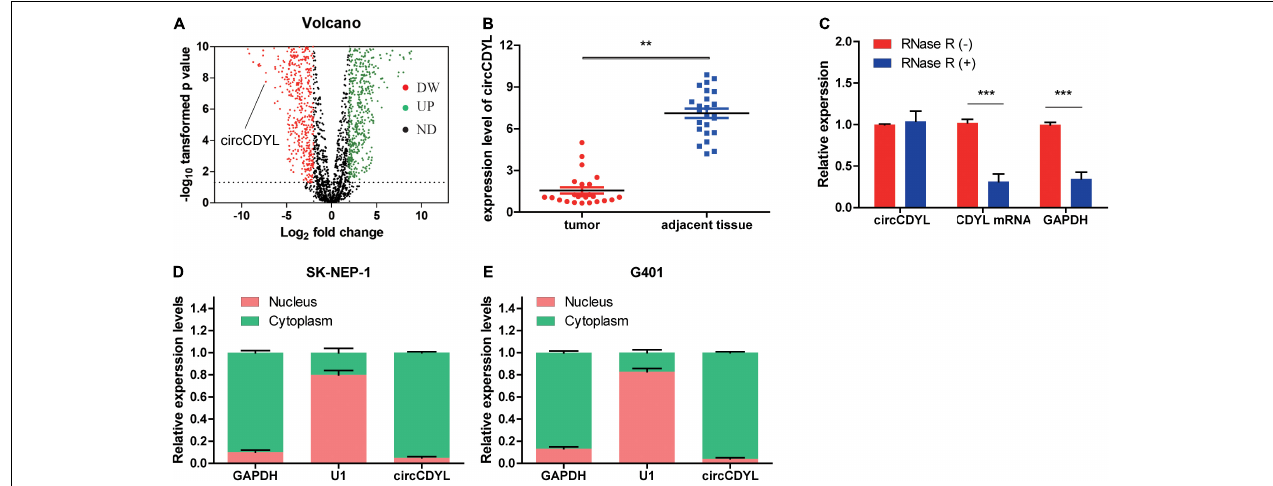
FIGURE 1 | CircCDYL is downregulated in WT tissue. (A) Volcano plot of differential circular RNA expression in WT tissue. The abscissa indicated logFC, and the ordinate indicated the differential log10 P -value. The gene was represented as a dot. The green dot indicated the upregulated gene, while the red dot indicated the downregulated gene. (B) The relative expression of circCDYL in WT tissue and adjacent normal tissue. (C) The relative expressions of circCDYL, mRNA CDYL, and GAPDH after treatment with RNase R. (D,E) circCDYL was mainly localized in the cytoplasm in both SK-NEP-1 and G401 cell lines. GAPDH and U1 were used as negative control, respectively. Student’s t -test with two biologically dependent or independent replicates was used to determine statistical significance; *** P < 0.001, ** P < 0.01, * P < 0.05.